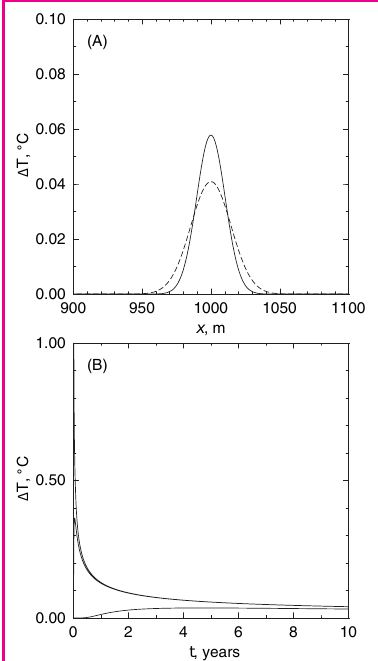
Figure 2. [A] Spatial and [B] temporal variations of temperature signature calculated for u = 6